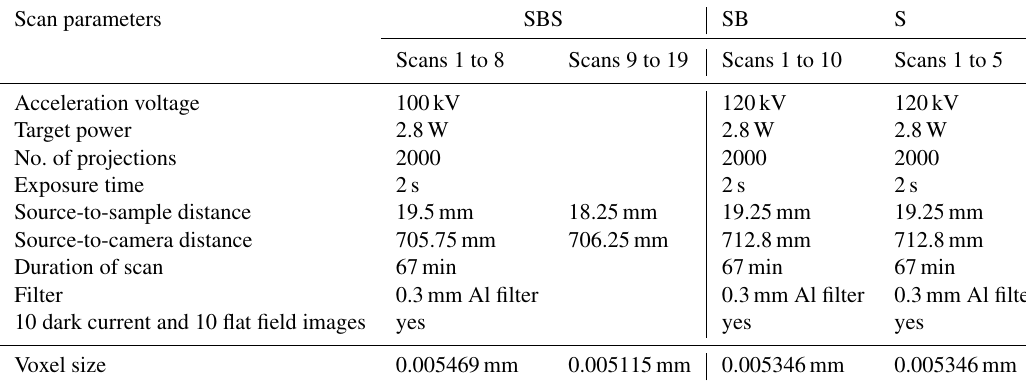
Table A2. Acquisition parameter for X-ray microtomography